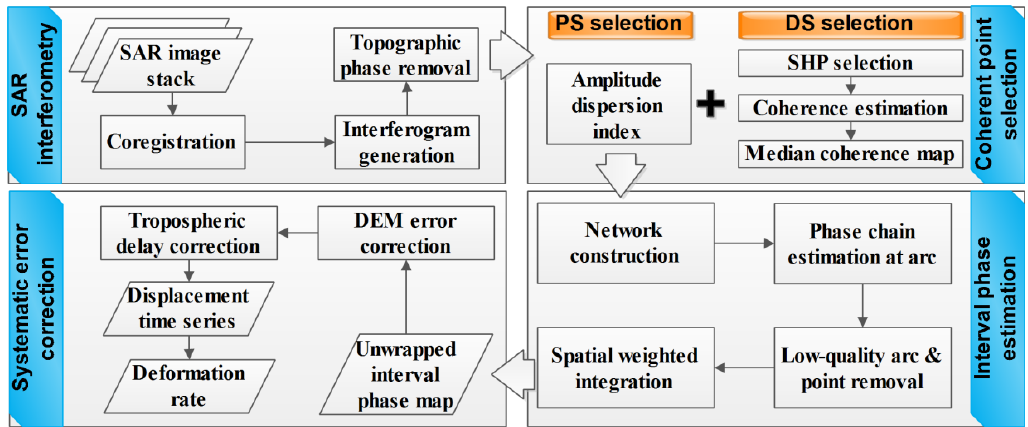
Figure 5. Flowchart of the modified MTInSAR method used in this study. PS refers persistent scatterer; DS refers distributed scatterer; SHP means statistically homogeneous pixel.